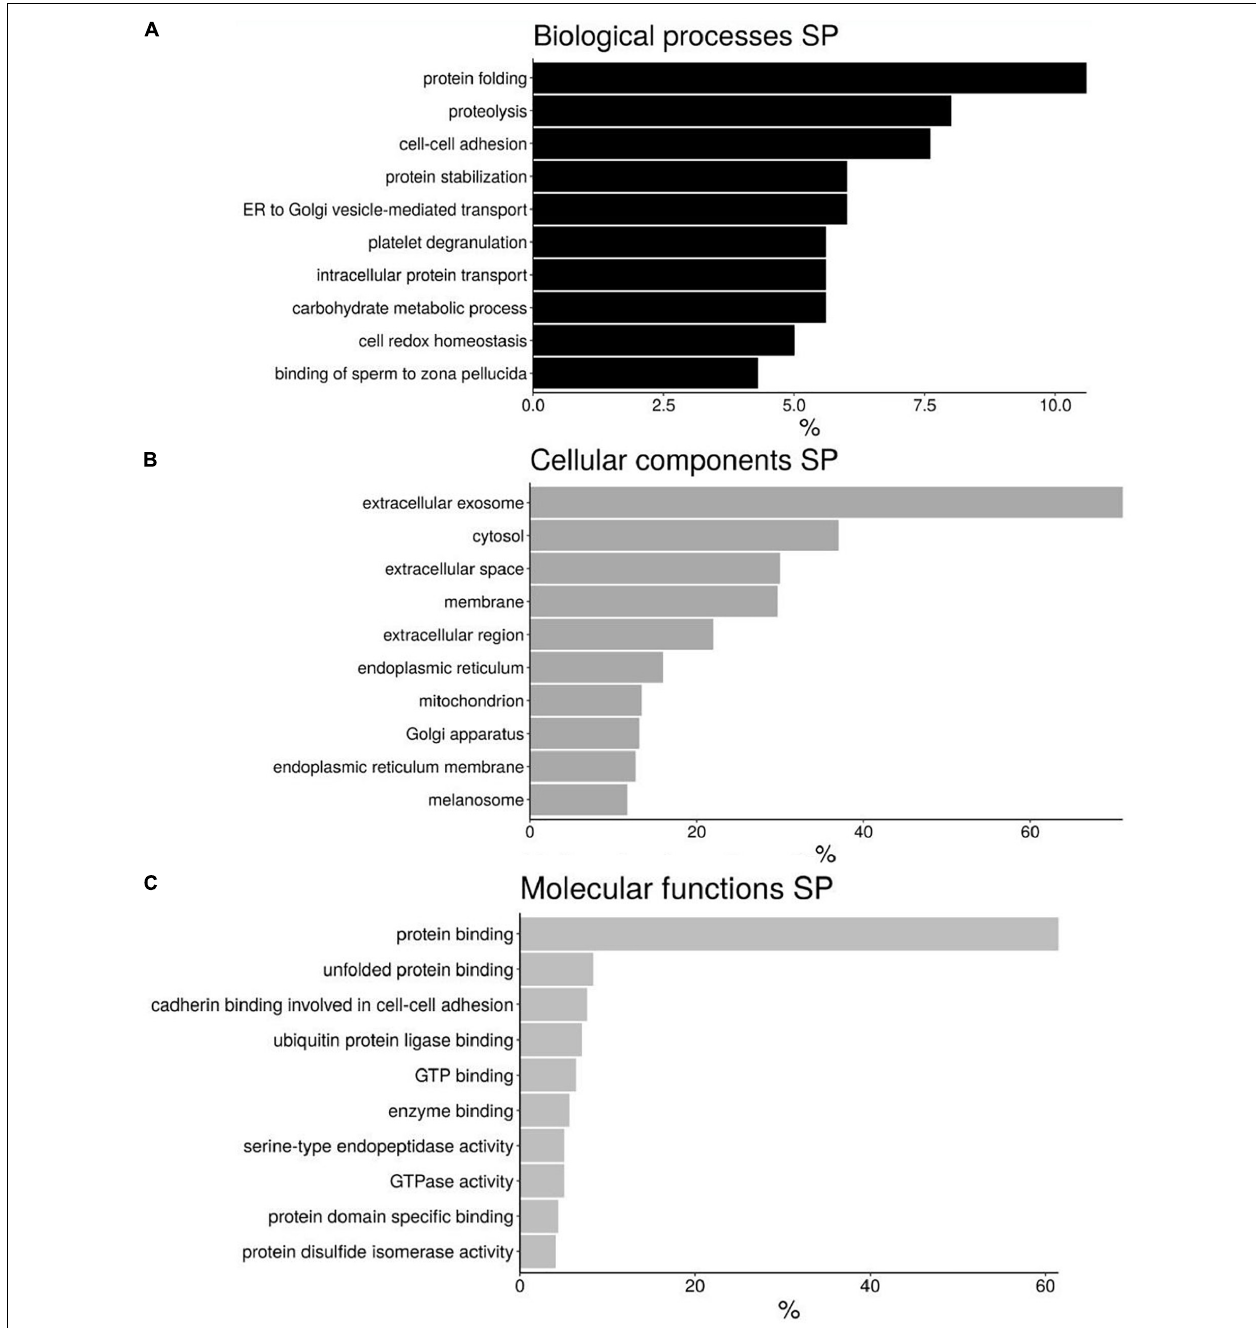
FIGURE 4 | Bar chart representing the gene ontology annotations of protein identified in bottlenose dolphin seminal plasma (SP) according to biological processes (A) , cellular components (B) , and molecular functions (C) .